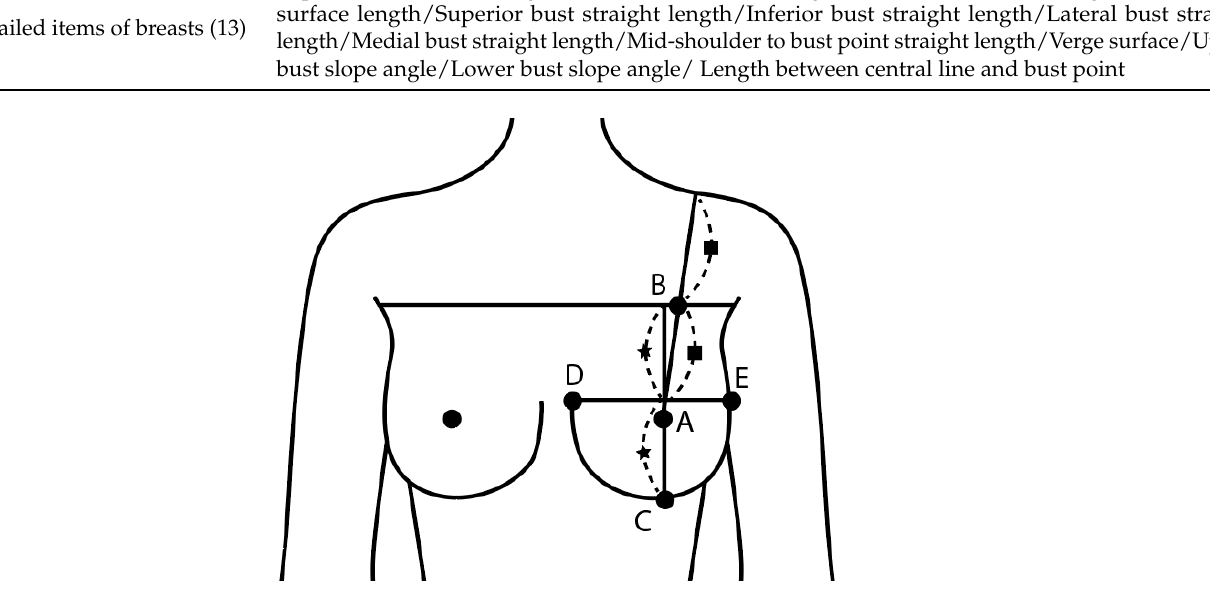
Figure 1. Measuring point on the bust (A: Bust Point, B: Superior Bust Point, C: Inferior Bust Point, D: Medial Bust Point, E: Lateral Bust